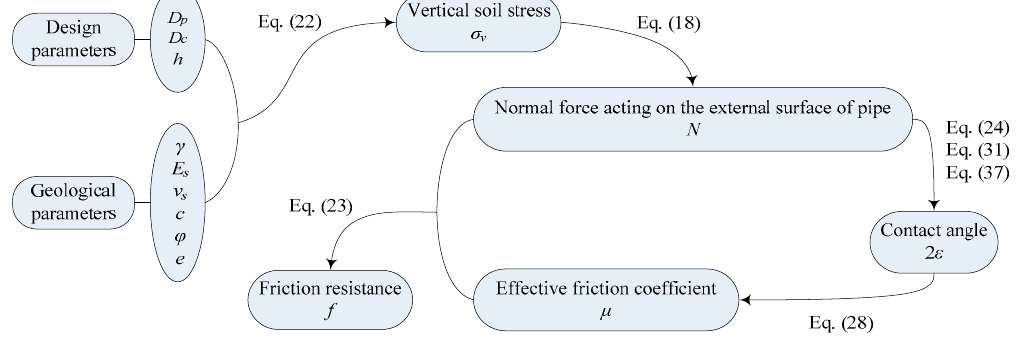
Figure 6. Flow chart of friction resistance prediction.